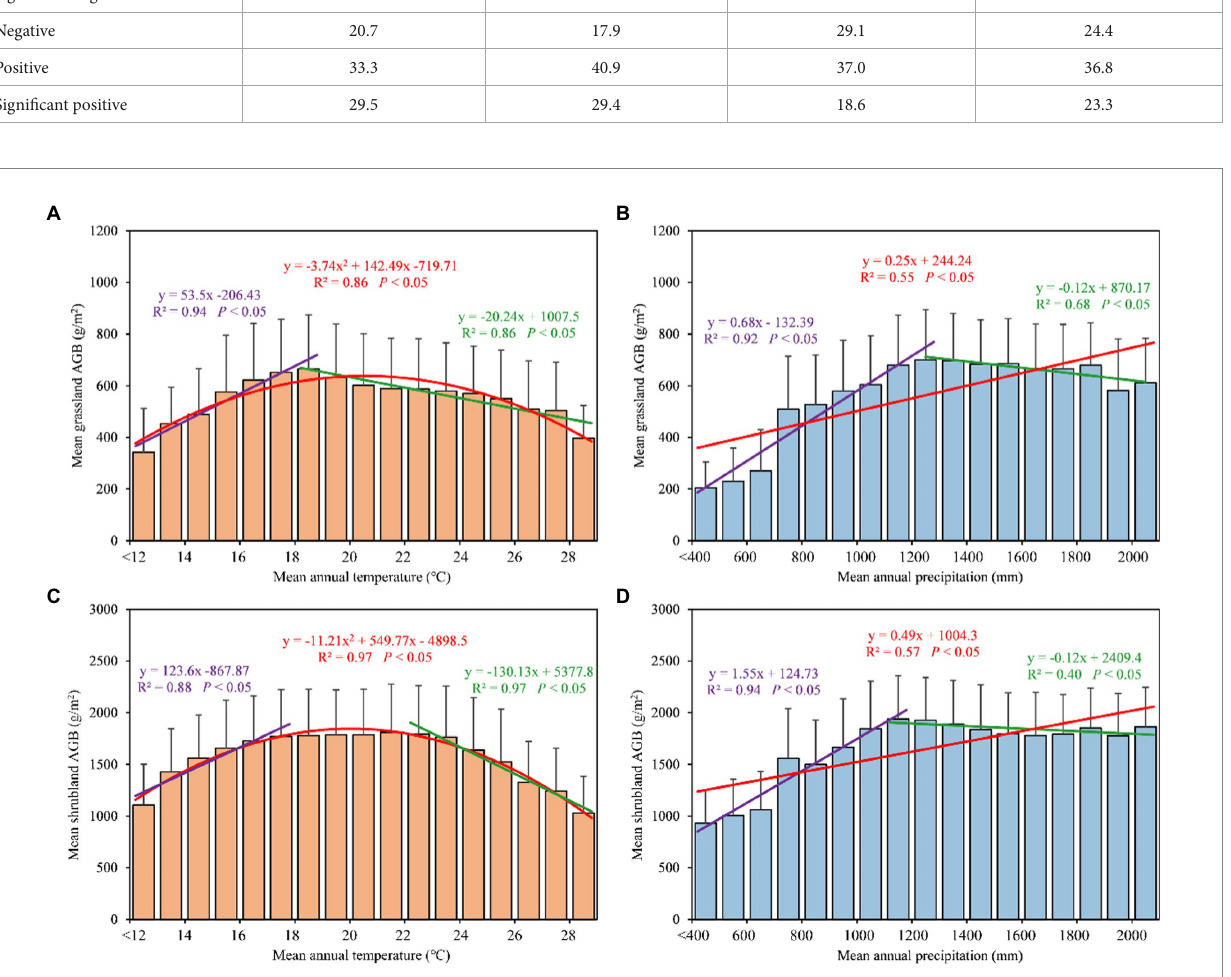
FIGURE 9 Relationship of average AGB of grassland (A and B) and shrubland (C and D) with MAT (2 ° C) and MAP (200 mm) gradients data from 2018 to